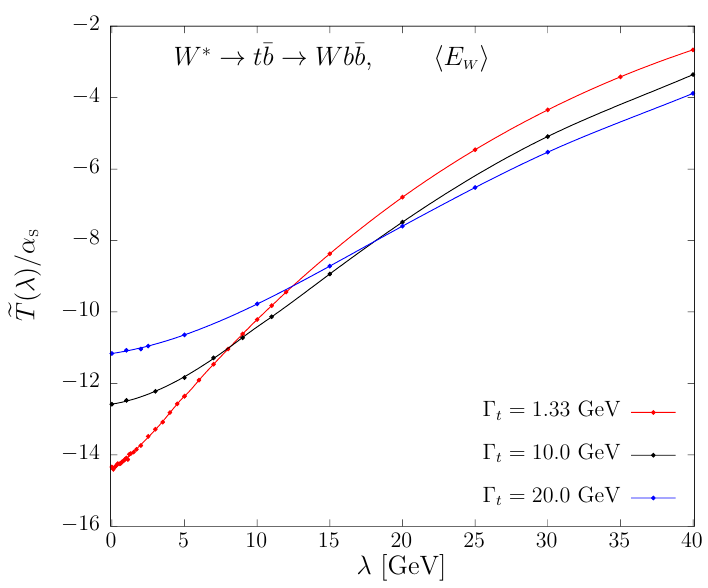
Figure 12 . Results for the small (cid:21) behaviour of e T for h E i , at di(cid:11)erent values of (cid:0) t . The error W bar associated to each point computed at a given value of (cid:21) is also plotted, but is too small to be visible on the scale of the (cid:12)gure. The red line ((cid:0) t = 1 : 33 GeV) is a 5 th order polynomial (cid:12)t for (cid:21) (cid:20) 5 GeV and a spline for larger (cid:21) values. The blue and the black solid lines, that interpolates the results obtained with (cid:0) t = 10 GeV and (cid:0) t = 20 GeV respectively, are a cubic (cid:12)t for (cid:21) < (cid:0) t and a spline for (cid:21) > (cid:0) t .